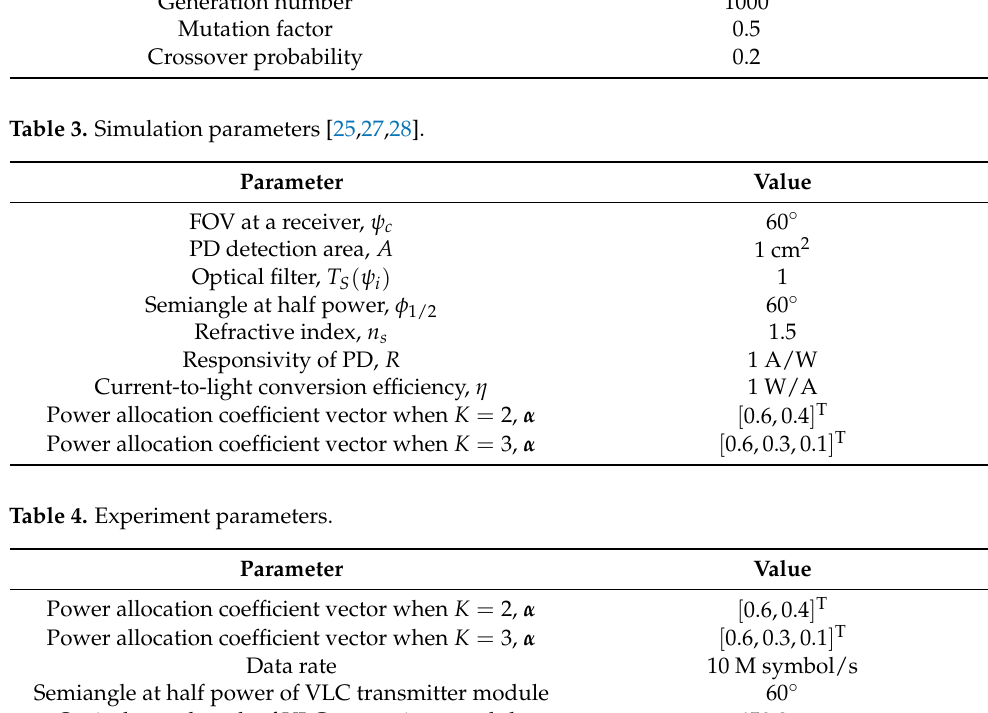
Table 2. DE algorithm parameters.